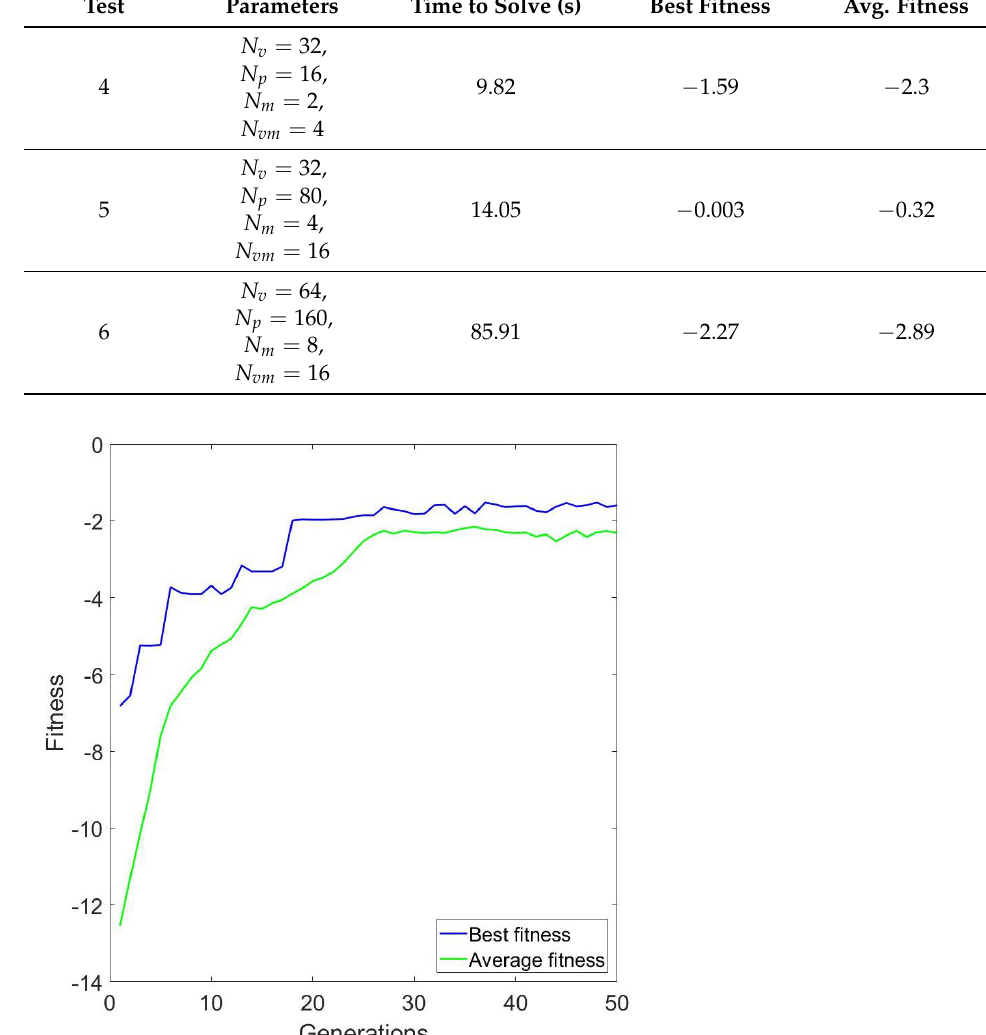
Figure 5. Average and best fitness using penalization for suboptimal NUMA placements and N v = 32, N p = 16, N m = 2, N vm = 4 as input.